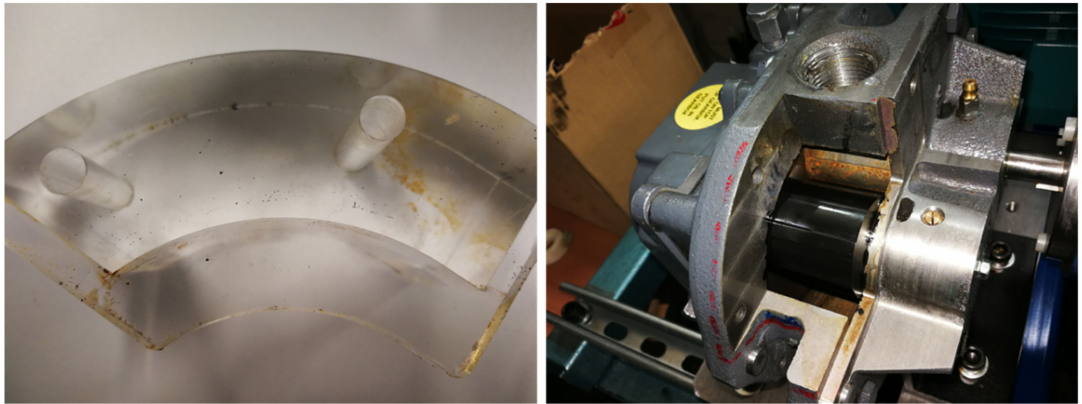
Figure 4. The original transparent window and the painted rotor.